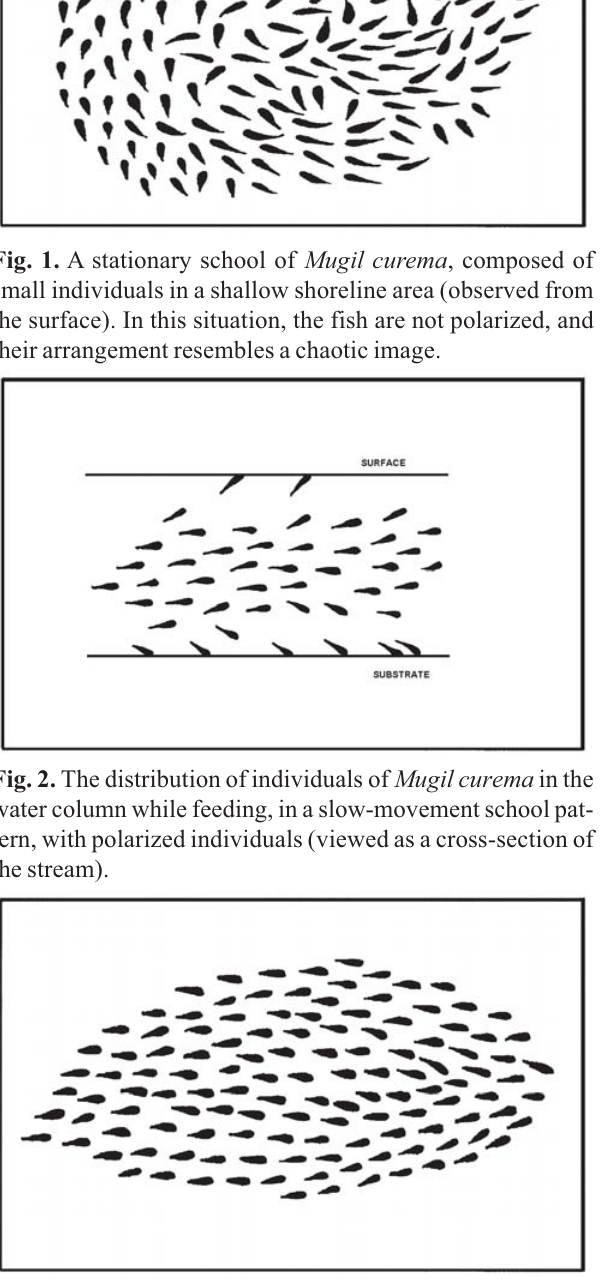
Fig. 3. A school of Mugil curema , in a fast movement pattern, with polarized individuals (observed from